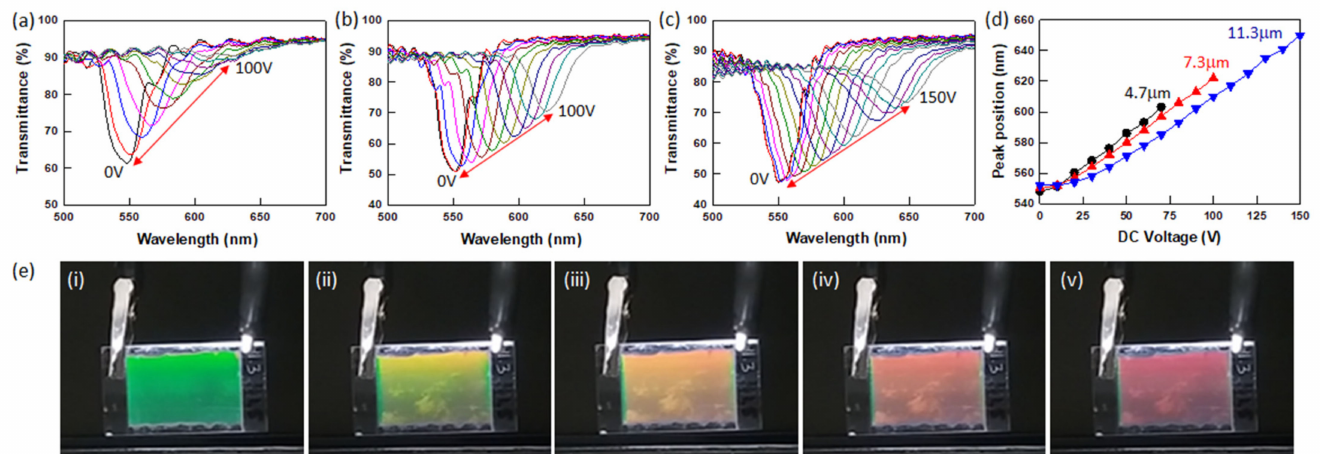
Figure 7. Red tuning response of PSBPLC-3 with ( a ) 4.7 µ m, ( b ) 7.3 µ m, and ( c ) 11.3 µ m thick- nesses with increasing DC voltage. ( d ) Summary of peak positions as a function of DC voltage. ( e ) Photographs of increasing DC voltages: ( i ) 0 V, ( ii ) 50 V, ( iii ) 90 V, ( iv ) 120 V, ( v ) 150 V